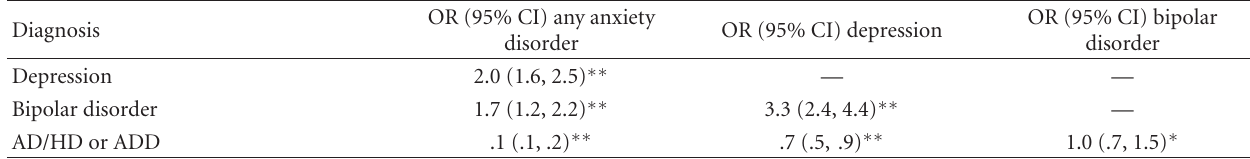
Table 3: Odds ratio (OR) of lifetime history of comorbidity among study participants with ASD, with at least one psychiatric comorbidity ( n =